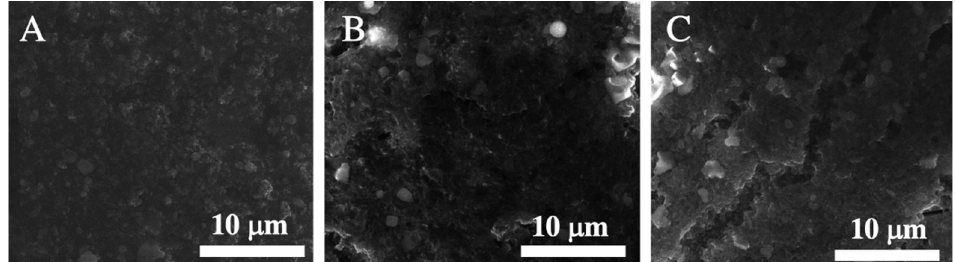
Figure 7. SEM images of samples after immersion in simulated body fluid (SBF) solution. ( A ) Produced by laser power of 5 W and immersed in SBF for 4 days; ( B ) produced by laser power of 9 W and immersed in SBF for 4 days and ( C ) produced by laser power of 12 W and immersed in SBF for 4 days.